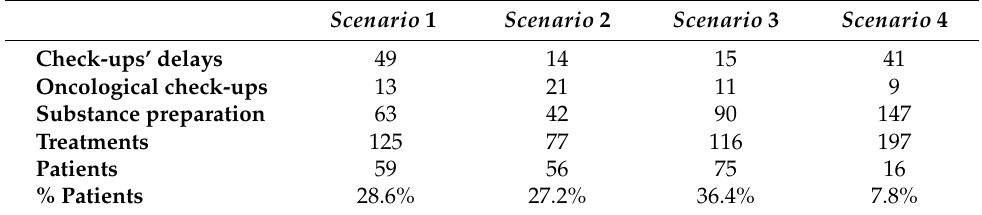
Table 5. Average times (minutes) for each scenario designed to apply the stochastic model.